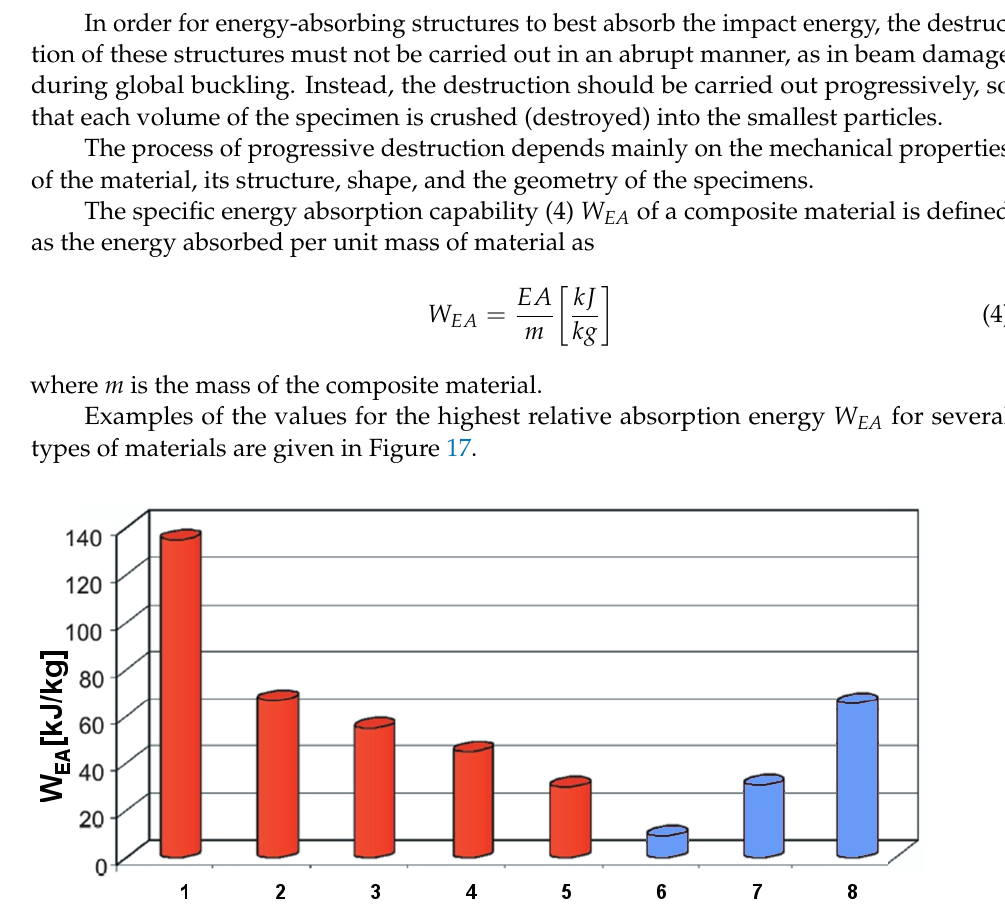
Figure 16. Results of dynamic impact tests of 1 mm Ti6Al4V sheet in layer structure of threes: ( a1 – a3 ) view from above; ( b1 – b3 ) view from bottom.